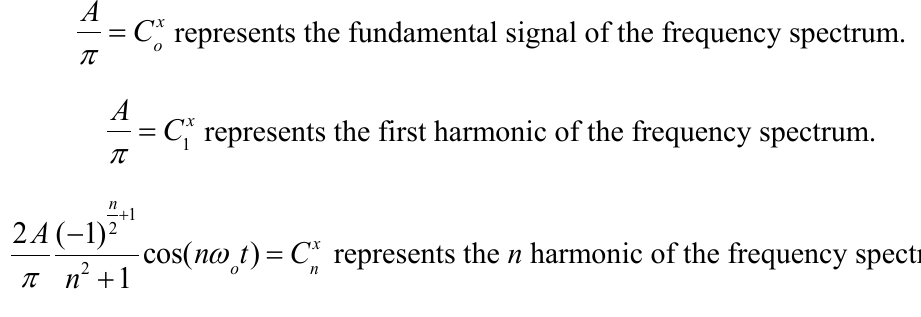
Figure 5. Frequency domain spectrum of the non-filtered PCB output voltage of the MEMS